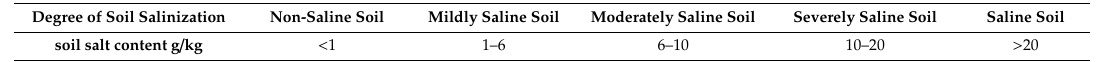
Table 1. Degree of soil salinization.